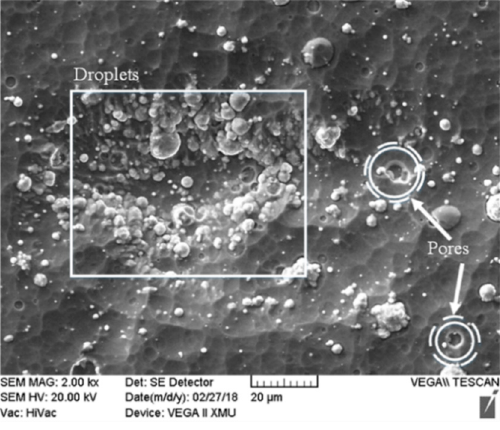
Figure 8. SEM image of TiN/ZrN coating after salt spray corrosion for 576 h.